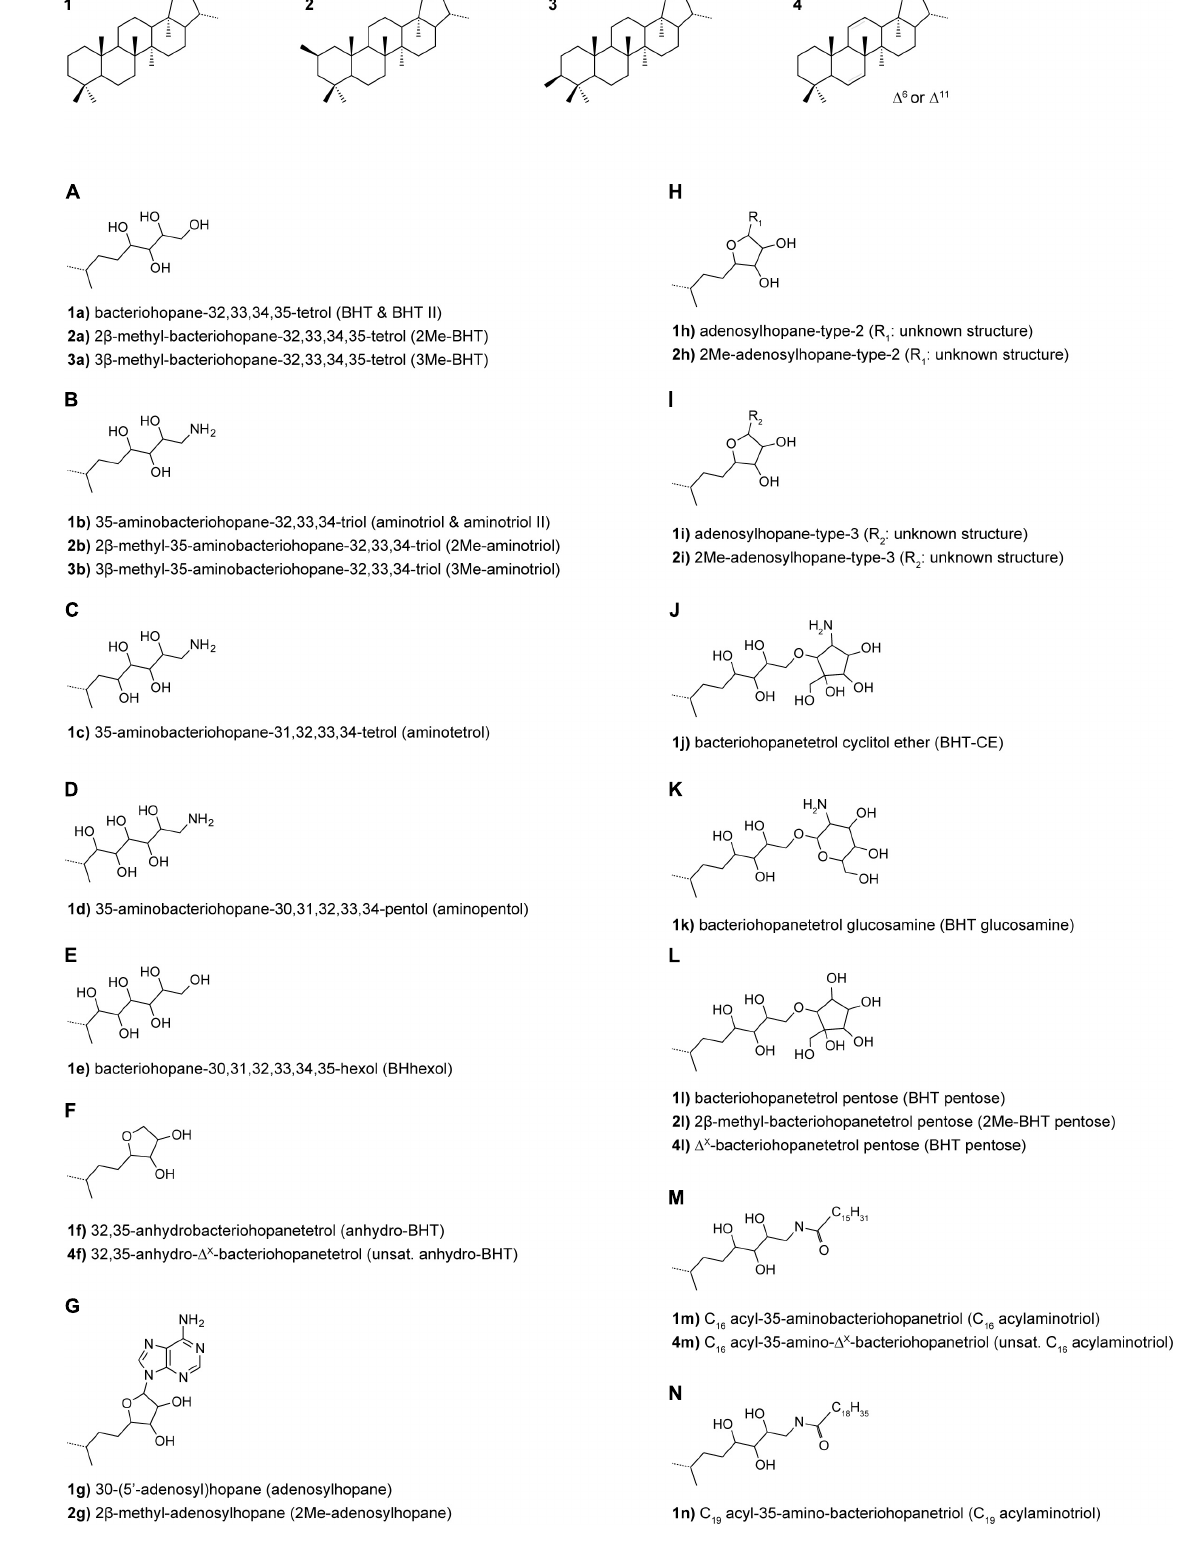
FIGURE 2 | BHP structures identified in this